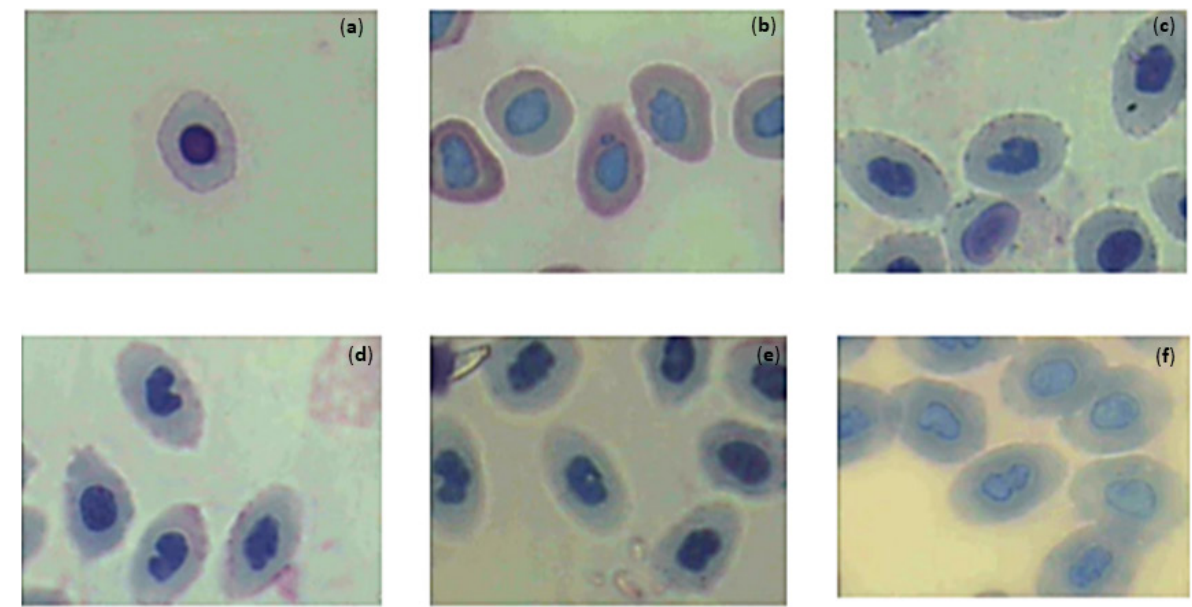
Figure 2 - Fish erythrocytes indicating the nuclear abnormalities as: ( a ) Normal; ( b ) Micronuclei; ( c ) Lobed; ( d ) Notched; ( e ) Vacuolizated; ( f ) Blebed. 1000-fold